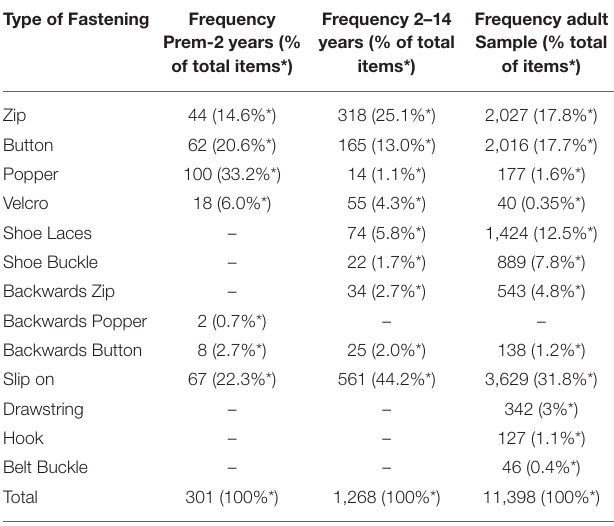
TABLE 2 | Frequency of clothing fastenings for children aged between 0-2 years, 2–14 years and adults. Type of